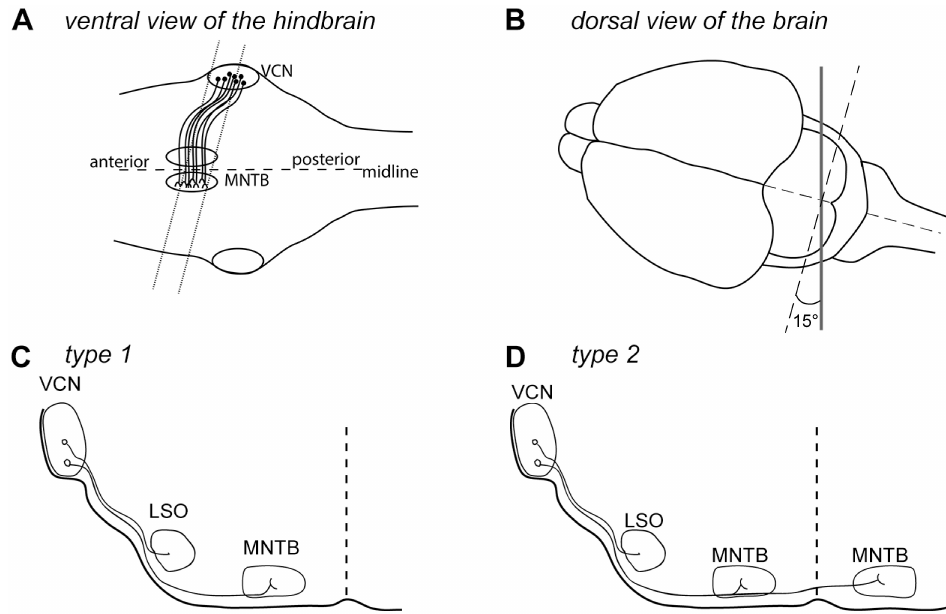
Fig 2. Modified angle during preparation of coronal hindbrain slices to preserve the VCN—MNTB connectivity. A , Ventral view of the brainstem. Based on severalobservationswith organotypic slice culturing of hindbraintissue from newbornmice, we infer that the MNTB nuclei are locatedmore anteriorlythan VCN (see also Fig 1A). The dashed line indicatesthe desired slicingconfiguration using the 15˚ rotation. B , Dorsal view of the slicing configuration. Grey line indicatesthe orientationof the tissue chopperblade. C , D , scheme of type 1 and type 2 organotypic slice cultures that we observed.